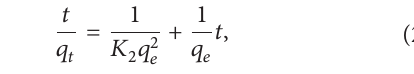
𝑒 values. This indicates that the pseudo-second-order